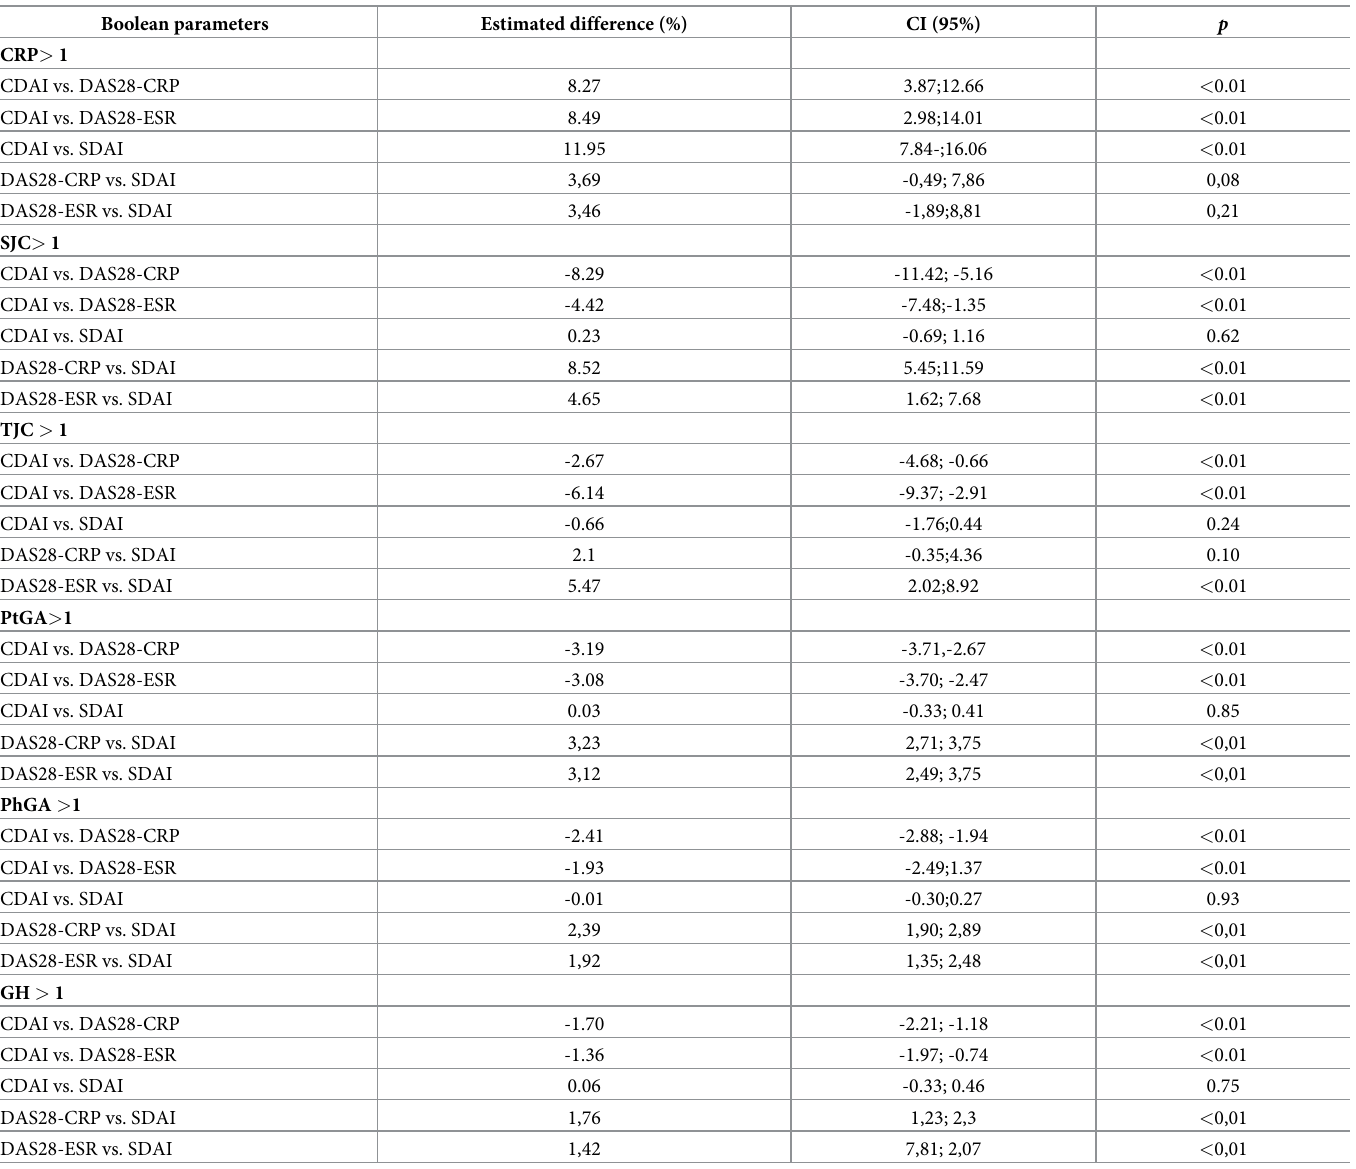
Table 6. Component estimated difference according to the composite activity